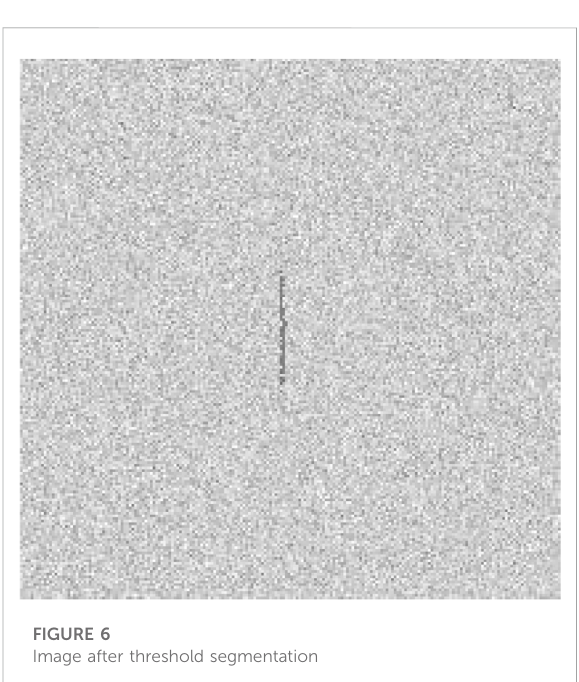
FIGURE 6 Image after threshold segmentation